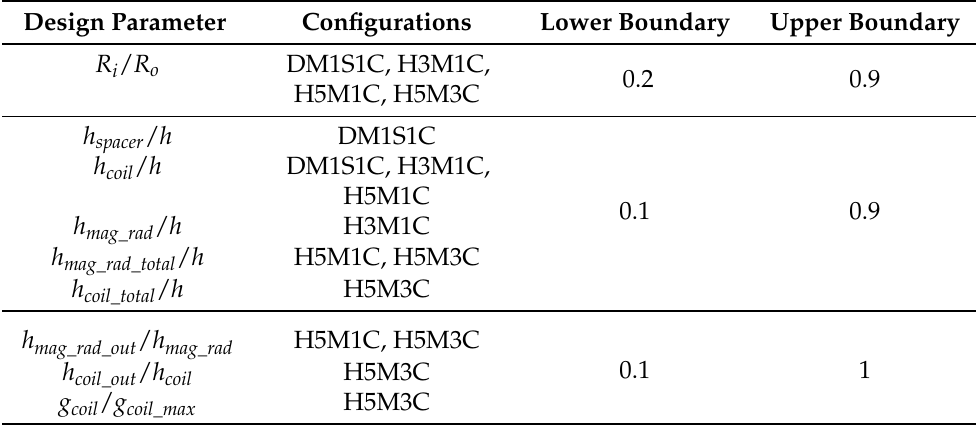
Table 3. Relevant design parameters of the harvester configurations, as well as their upper and lower